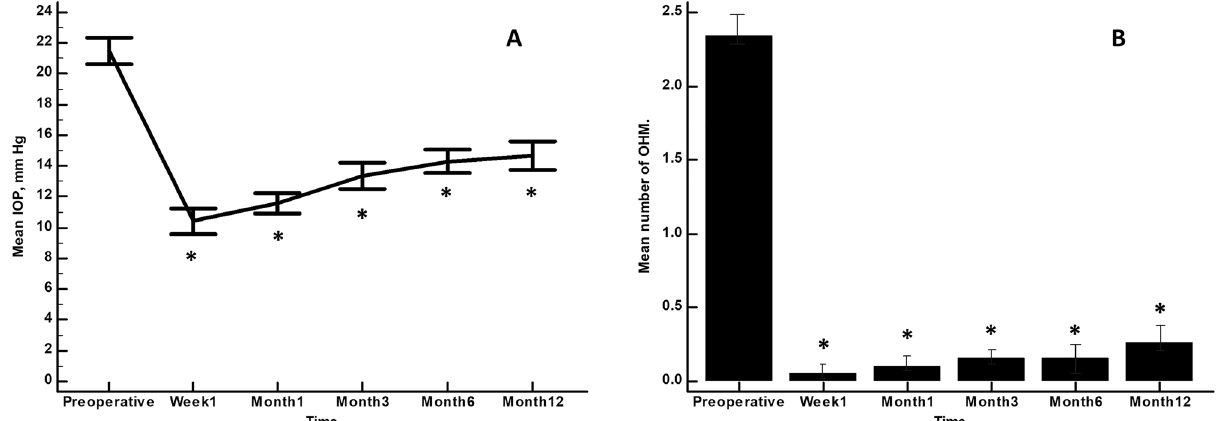
Figure 1. Overview of the mean intraocular pressure ( A ) and number of ocular hypotensive medications ( B ) throughout the study. Vertical bars represent 95% confidence interval. *p < 0.0001 as compared to baseline (repeated measures ANOVA and the Greenhouse–Geisser